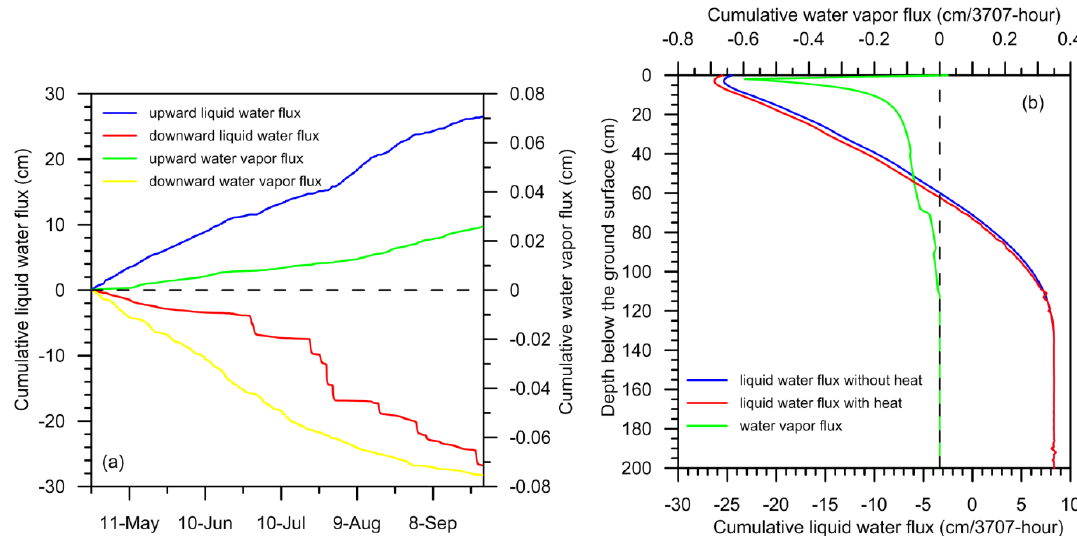
Figure 12. Changes in the cumulative liquid water and water vapor flux with time ( a ) and with depth; ( b ) during the investigation period.